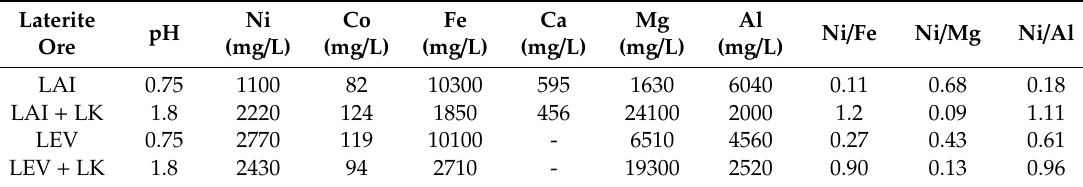
Table 7. E ffi ciency of H 2 SO 4 leaching of LAI (24 h) and LEV (6 h) laterites under the following